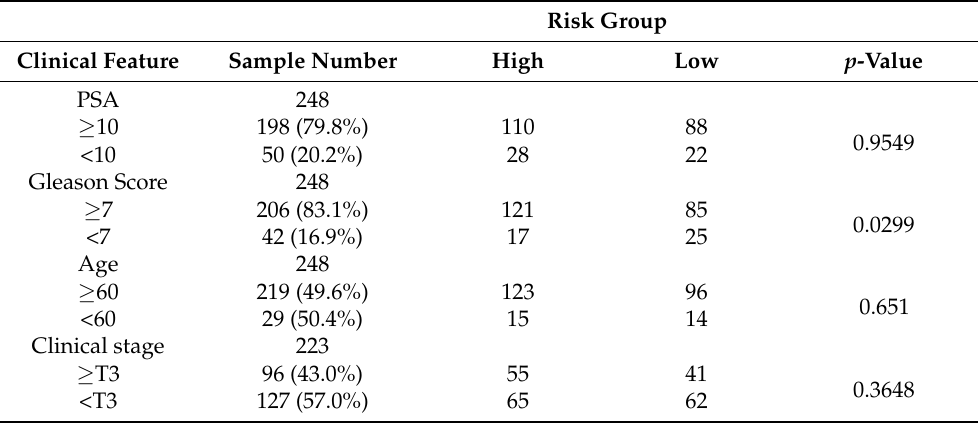
Table 3. Correlations between Clinicopathologic Features and the Risk Score in the Validation Set.